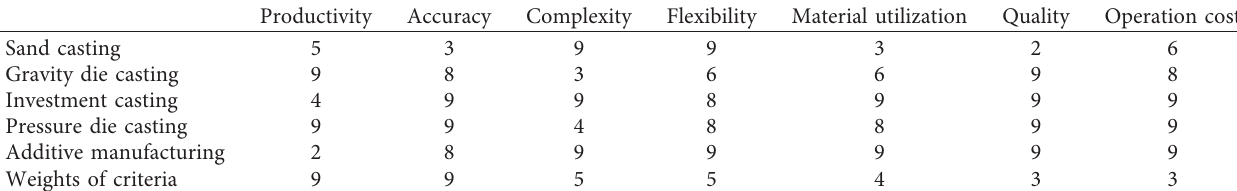
Table 5: The assessment of decision makers for the criteria and the manufacturing processes.